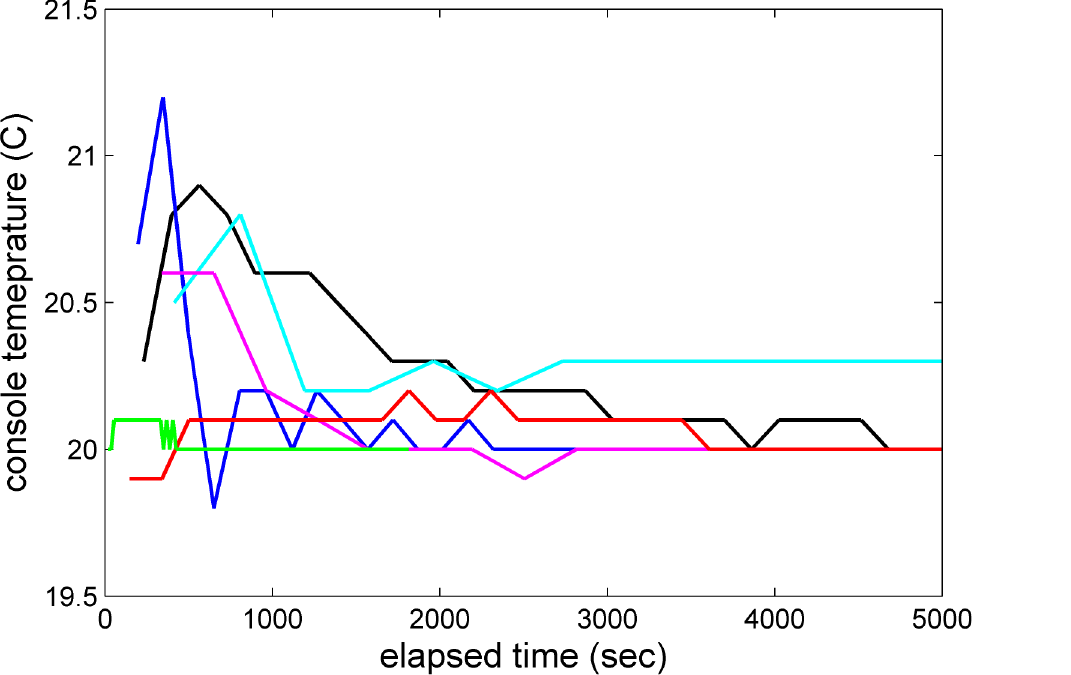
Fig 6. Examples of transient changes in the console temperature reading during the SV experiment, as saved in the scan file data. For comparison, the maximum adiabatic cooling of -0.3°C would be expected after approximately 300 sec, recovering to the equilibrium temperature after approximately 1,200 s (see Fig 3 in